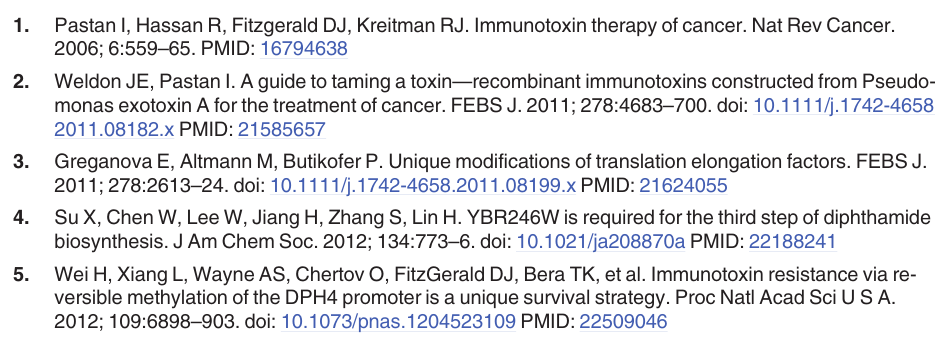
quent 6 days. Data is the average of two independent experiments. S3 Fig. 147-bp nucleotide sequence in the mesothelin promoter region. The methylation sta- tus of the CGs (in bold) is analyzed by bisulfite pyrosequencing. S4 Fig. Gene set enrichment analysis database analysis reveals a hypermethylated state in KLM-1-R. RNA sequencing analysis on KLM-1 and KLM-1-R cells demonstrated significant changes in methylation patterns as shown by Qlucore ’ s functional analysis based on gene set enrichment analysis (GSEA) genes. The GSEA set “ missiaglia_regulated_by_methylation_dn ” , generated by treating PDAC cell lines with AZA [39], showed high similarity to our data. Of the 122 down-regulated genes in this GSEA, 97 (80%, in green) were also down-regulated in KLM-1-R, whereas 20 genes (16%, in red) were up-regulated and 5 genes (4%) were not over- lapping. S1 Table. Primer sequences for RT-qPCR. S2 Table. List of differentially up- or down-regulated genes in KLM-1-R versus KLM-1-R as determined by RNA sequencing